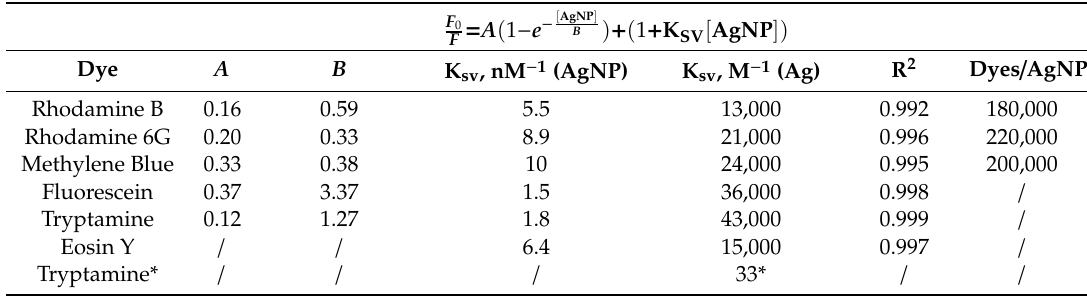
Table 3. Mathematical fitting results for all dye